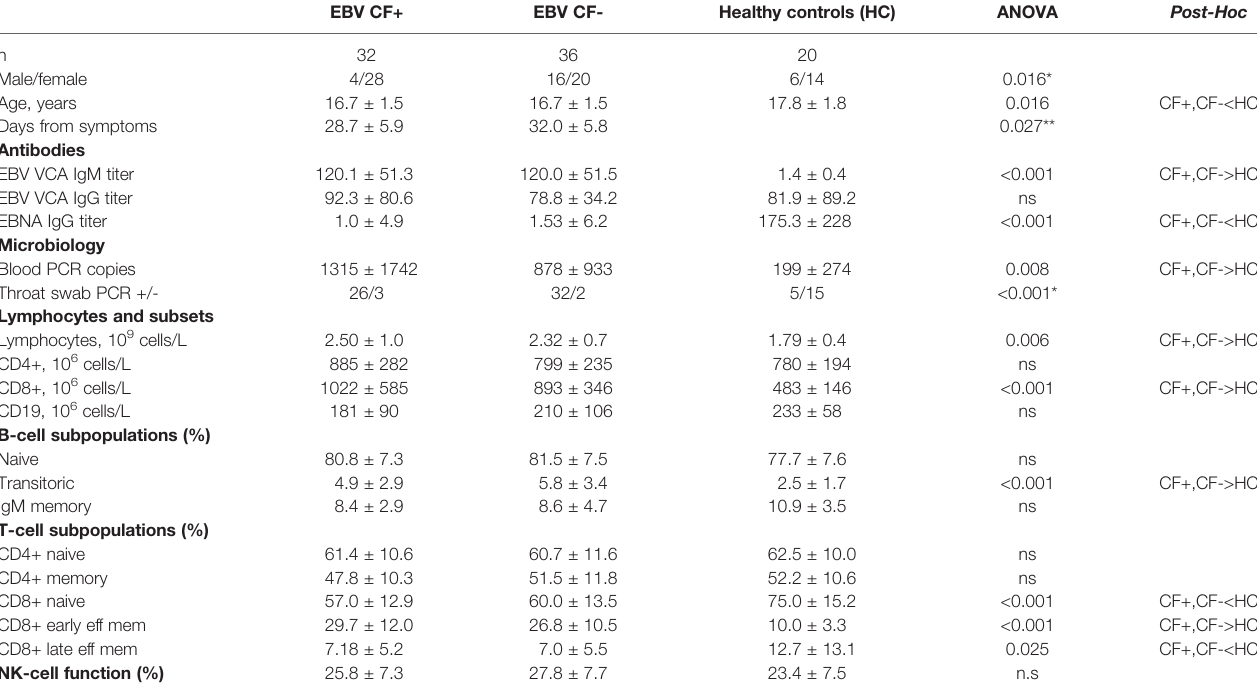
TABLE 1 | Demographic and clinical characteristics of EBV patients in the in vitro cohort at